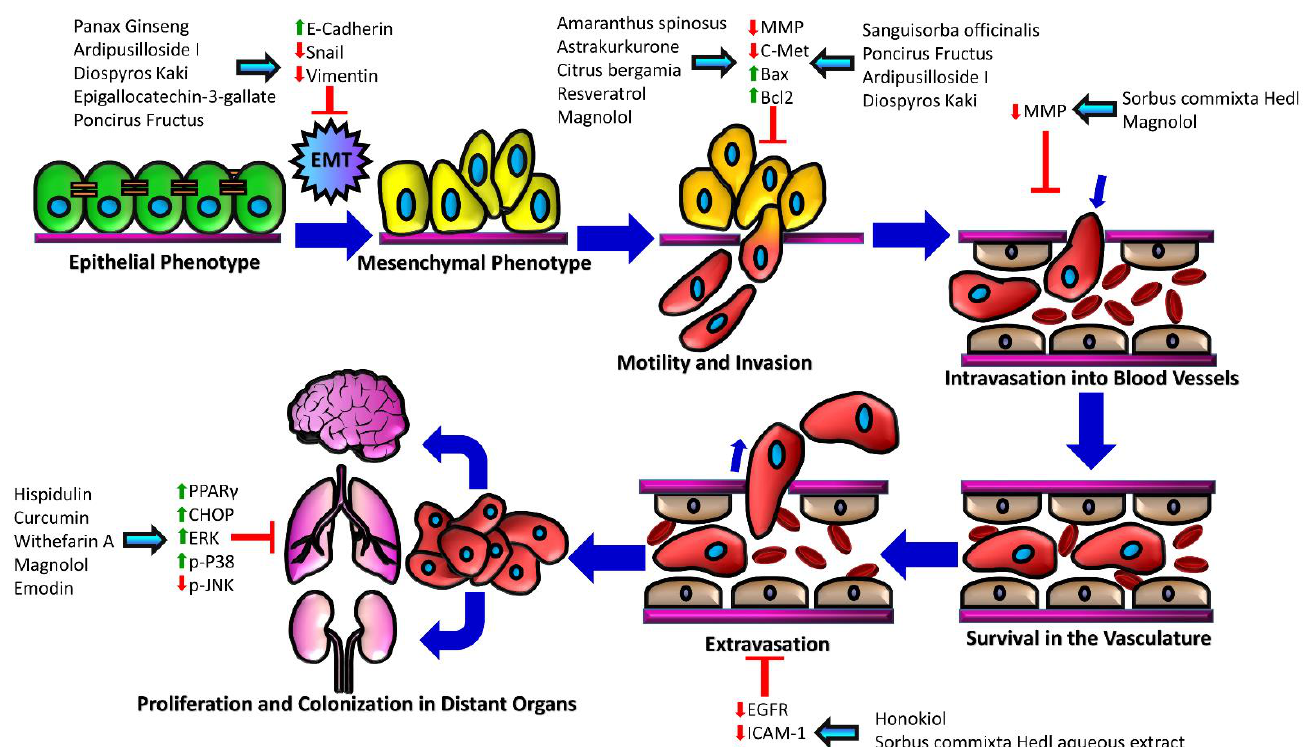
Figure 2. Phytochemicals target crucial molecular signaling markers involved in various key processes of HCC metastasis. Several phytochemicals inhibit specific stages of HCC metastasis, such as epithelial–mesenchymal transition (EMT), motility, invasion, intravasation, extravasation, and colonization in distant organs. Table 1. List of natural compounds and their mechanism of action on hepatocellular carcinoma from preclinical studies . Plant Compound Study Type Cell Type Mechanism of Action